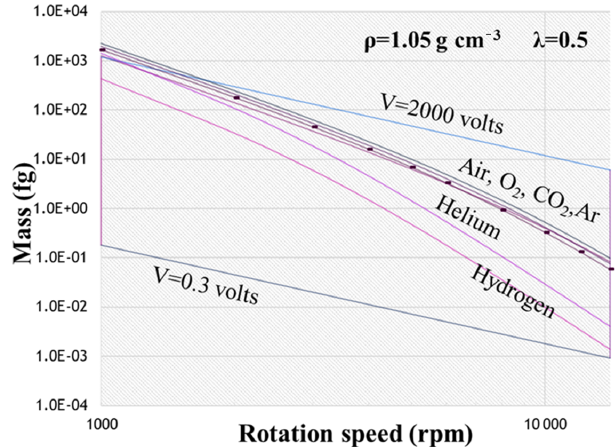
Figure 1. Operational region of